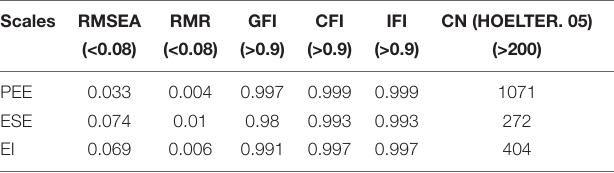
TABLE 2 | Models of the Confirmatory Factor